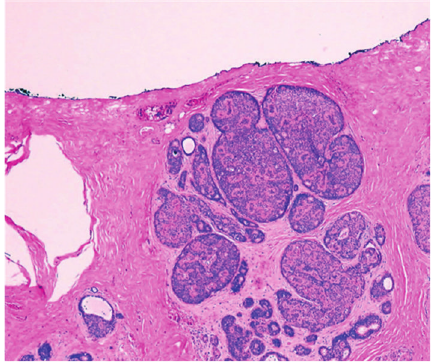
Figure 3: Section of ductal carcinoma in situ close to a margin but not surgically transected. There is some agreement that a clearance less than 2mm is inadequate and places a patient at high risk for residual disease. (H and